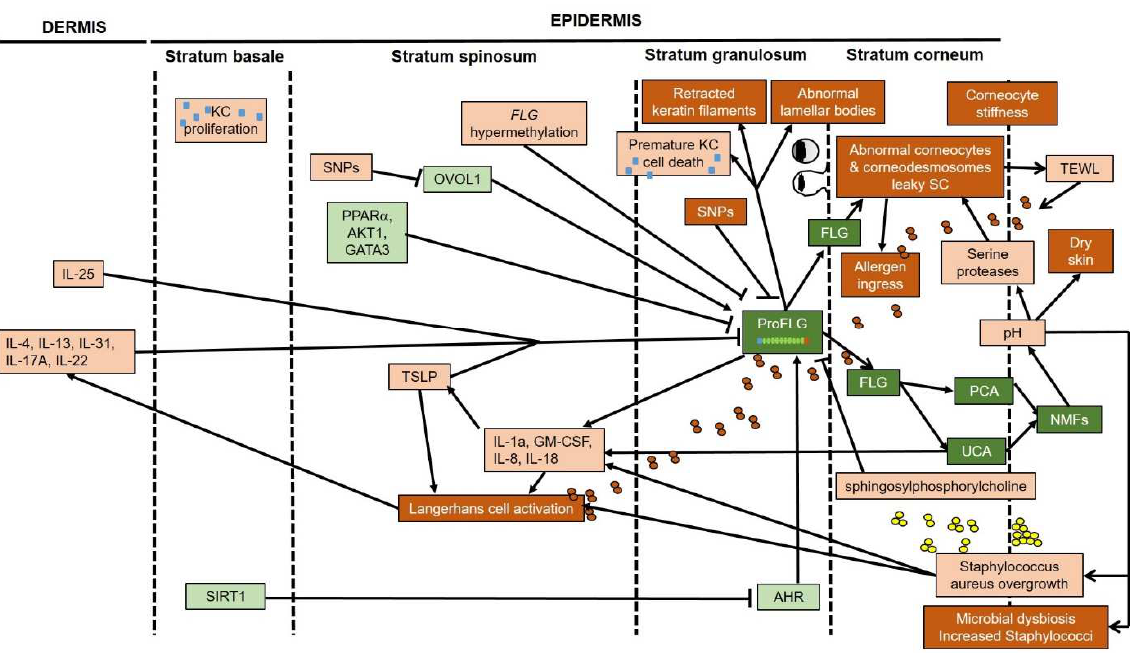
Figure 3. Summary of filaggrin regulation and roles in atopic dermatitis: experimentally confirmed roles (darkest boxes, white writing) versus prevailing ideas, most of them unsubstantiated. Decreased parameters are in green boxes, and increased parameters are in orange boxes.